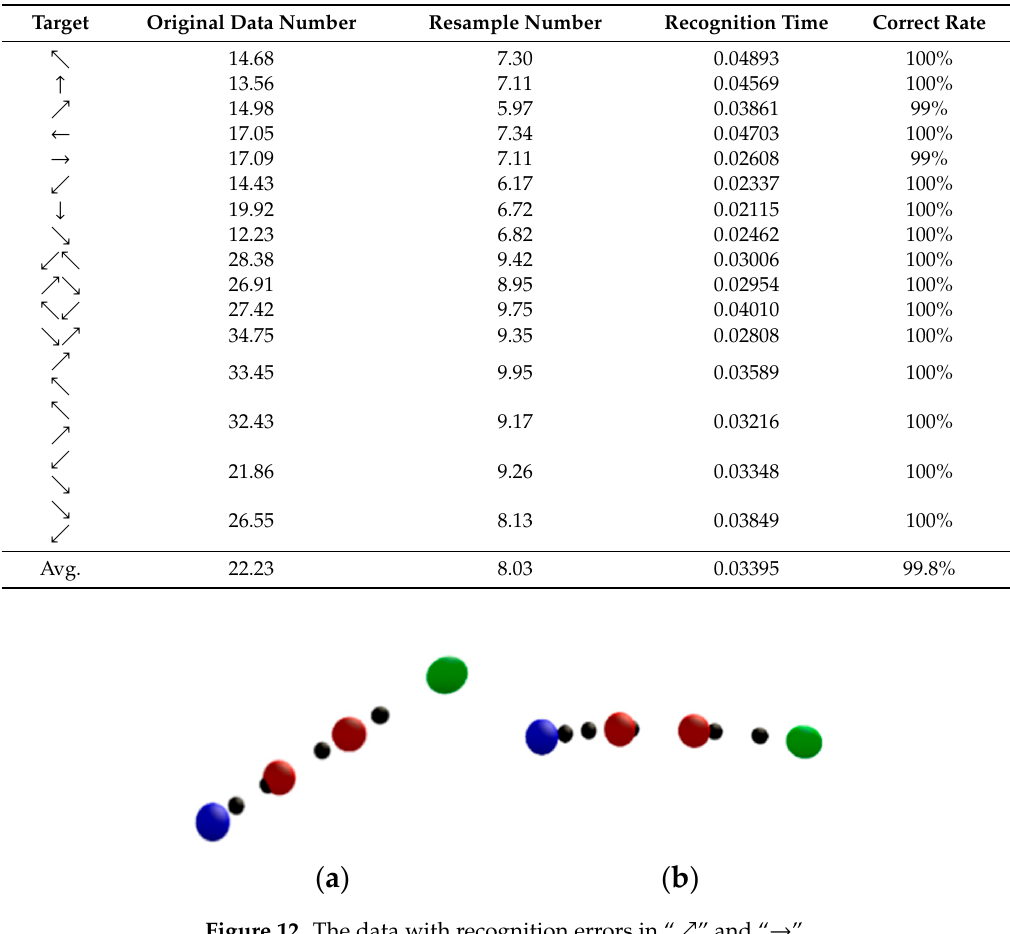
Table 7. The result of 16 kinds of recognition targets executed 100 times.